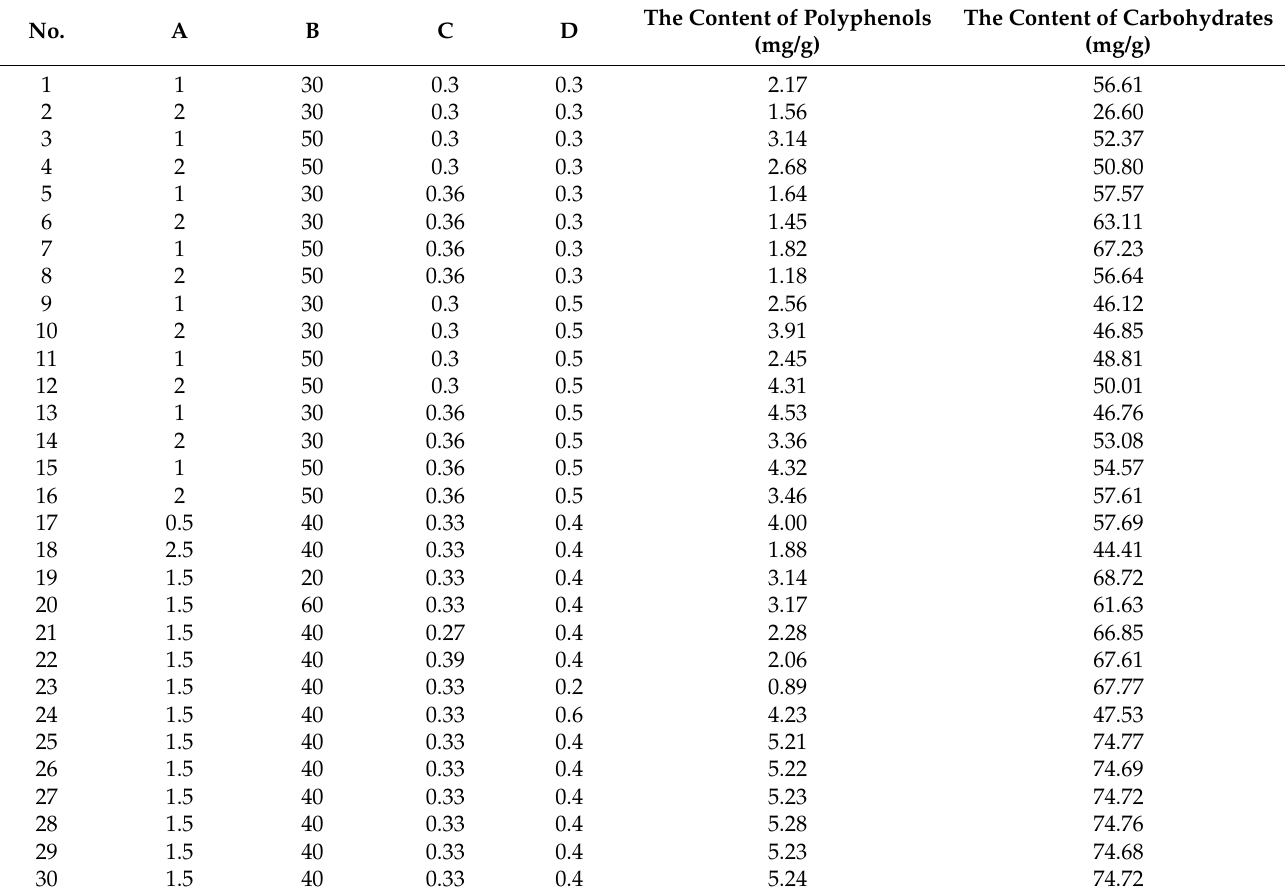
Table 2. Response Surface Experiment Scheme and Results.